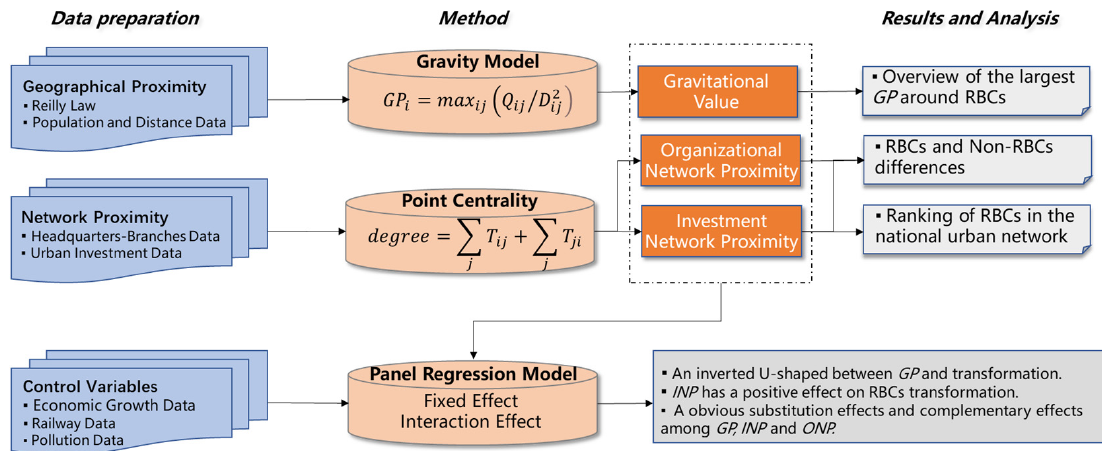
Figure 1. Technical framework for this study.